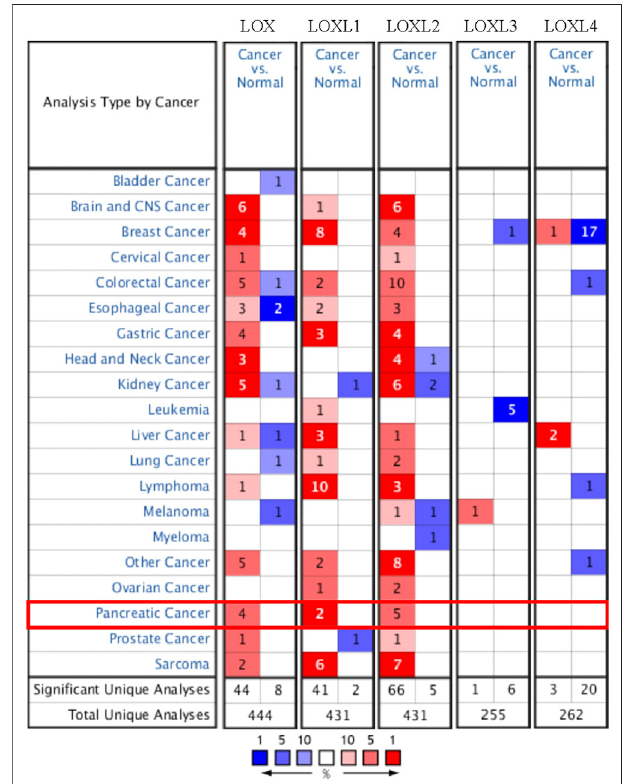
table represented the studies with statistically signi fi cant tumor tissue mRNA overexpression (red) or down-expression (blue), and LOX, LOXL1, and LOXL2 expression were upregulated in PDAC